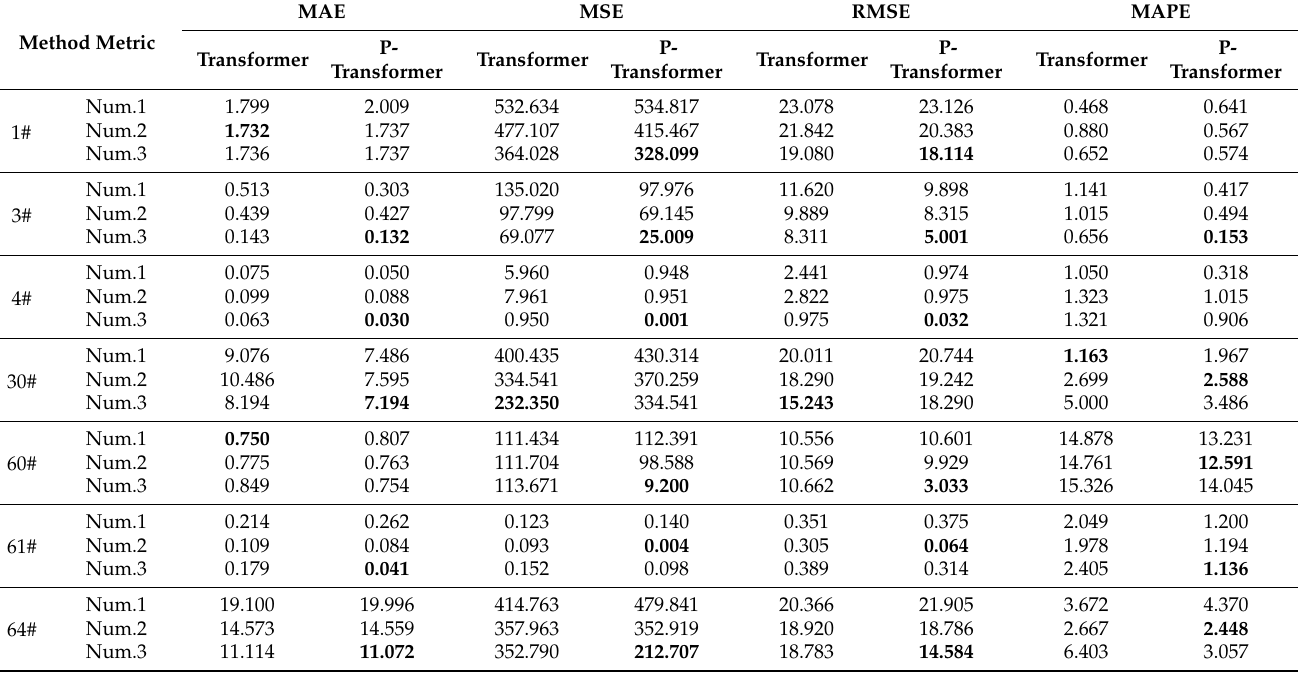
Table 2. The metrics of the P-Transformer and Transformer algorithms on different